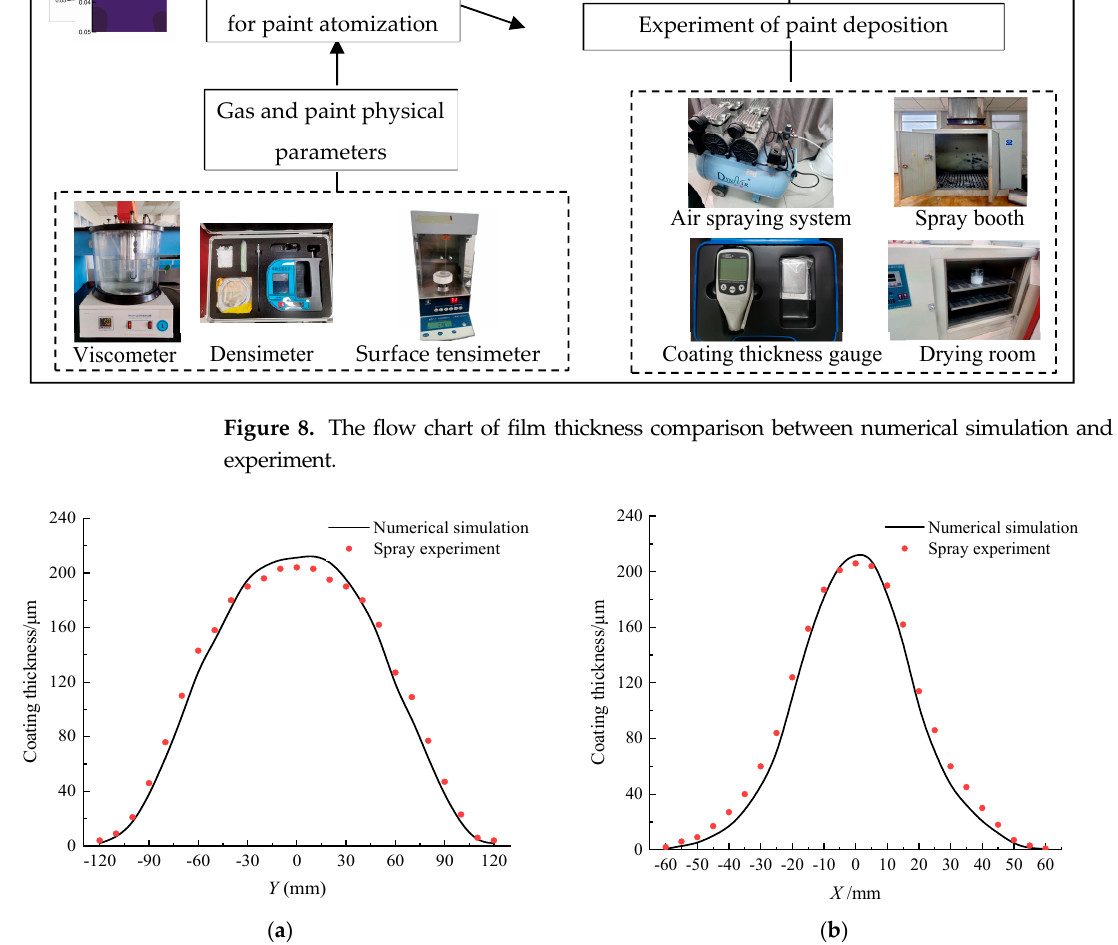
Figure 9. Comparison of paint film thickness. ( a ) Paint film thickness distribution along the long axis. ( b ) Paint film thickness distribution along the short axis.